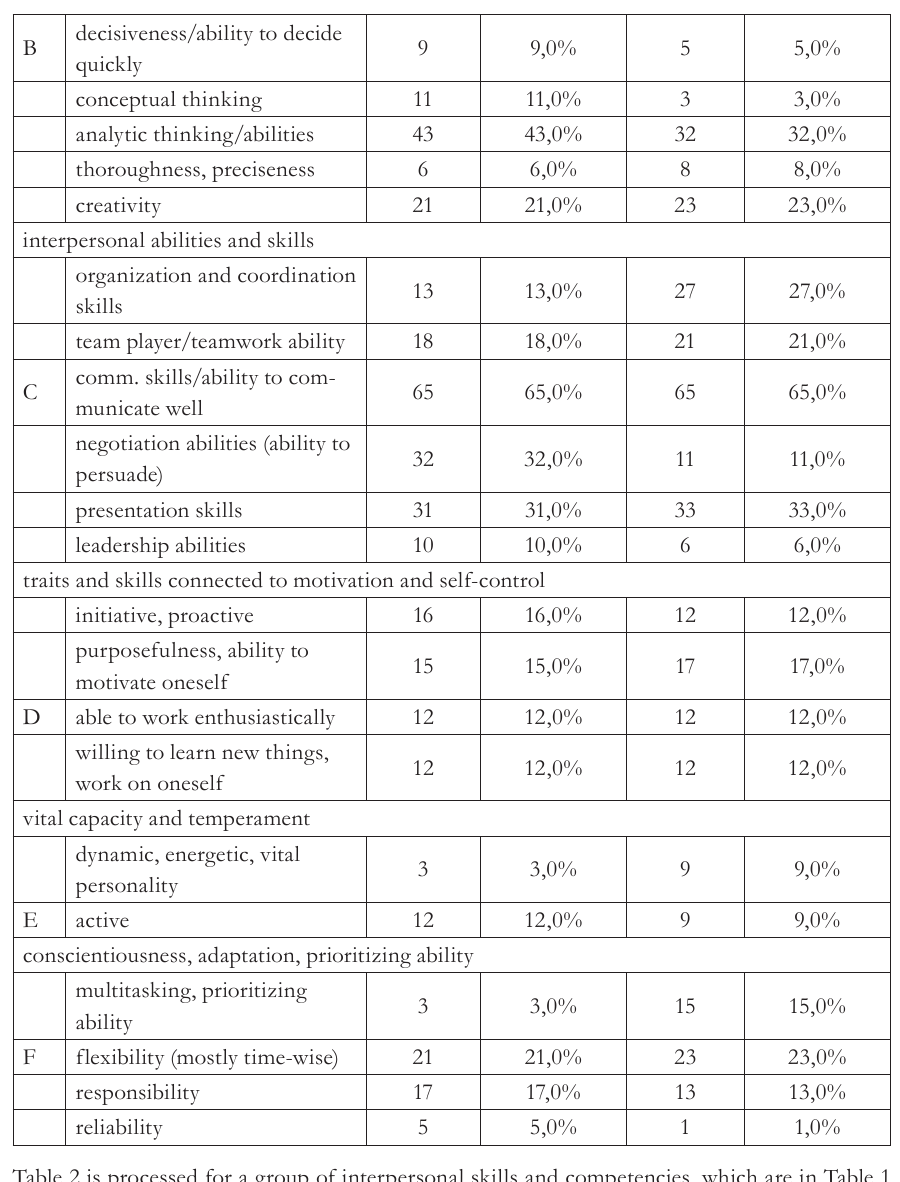
Table 2 is processed for a group of interpersonal skills and competencies, which are in Table 1 under